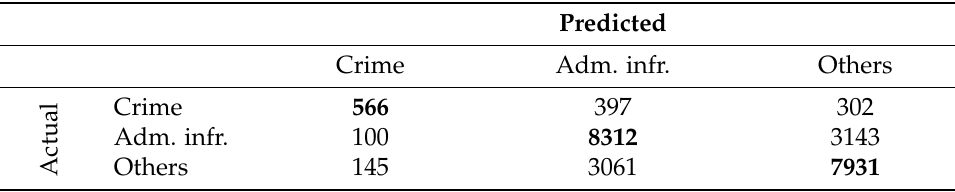
Table 8. Infraction severity prediction confusion matrix using SVM.